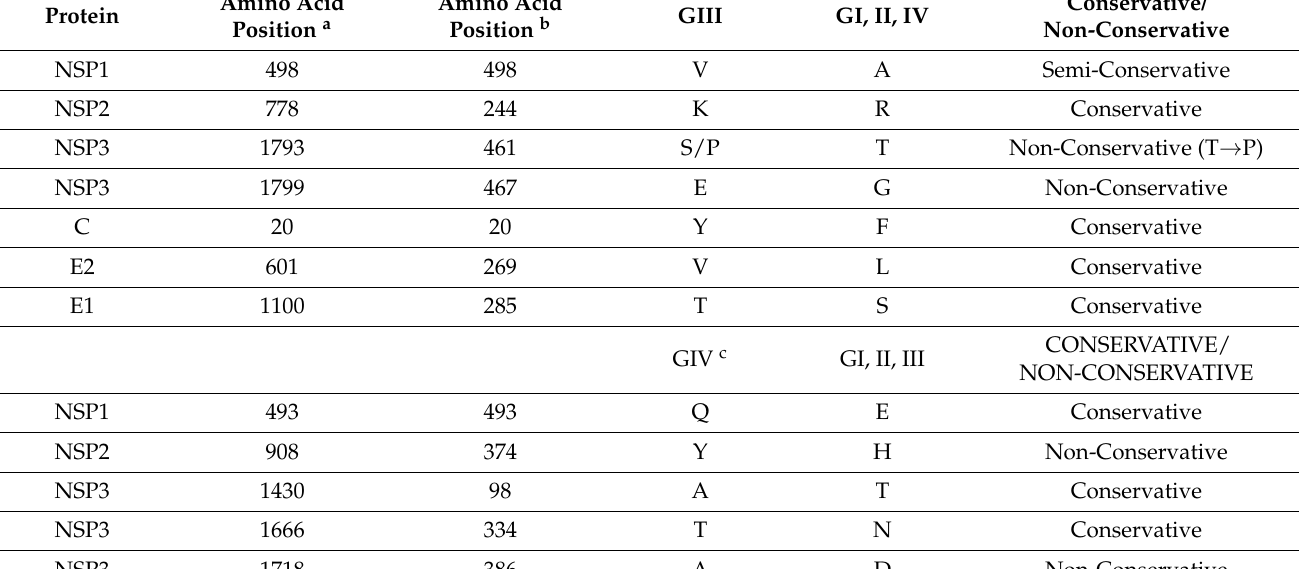
Table 1. Structural and non-structural protein amino acid substitutions specific to GETV GIII and